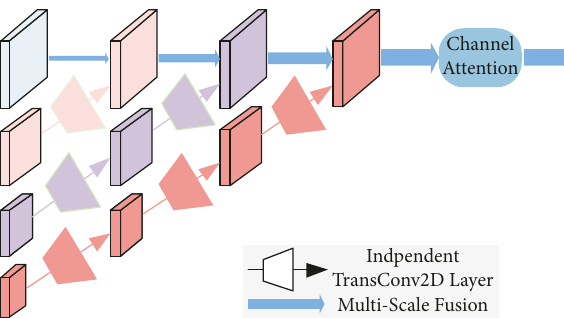
Figure 4: Structure of multiscale fusion in the recognition